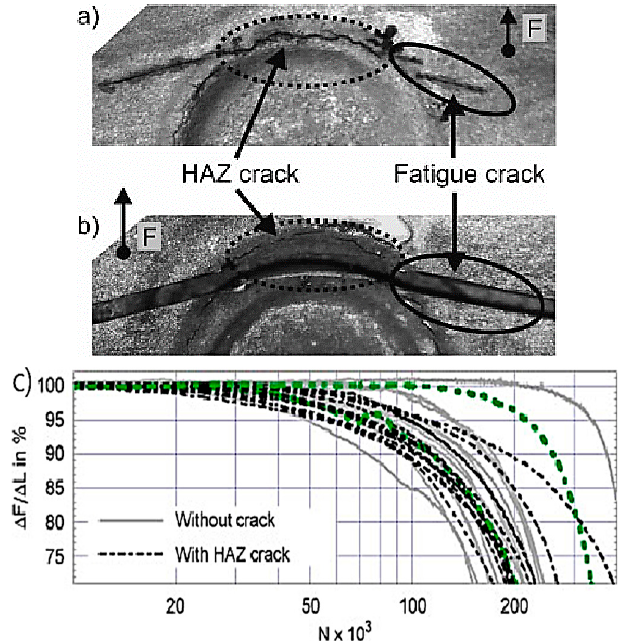
Figure 16. Influence of HAZ crack on fatigue life of resistance spot welded GI TRIP 700 steel. ( a , b ) Direction of fatigue force depicted as arrowed “F”, ( c ) stiffness characteristics of crack-free (solid line), HAZ cracked (black dotted line), crack combined (light black dotted line). Reprinted from [102], with permission of Taylor and Francis, 2011, http://www.tandfonline.com.